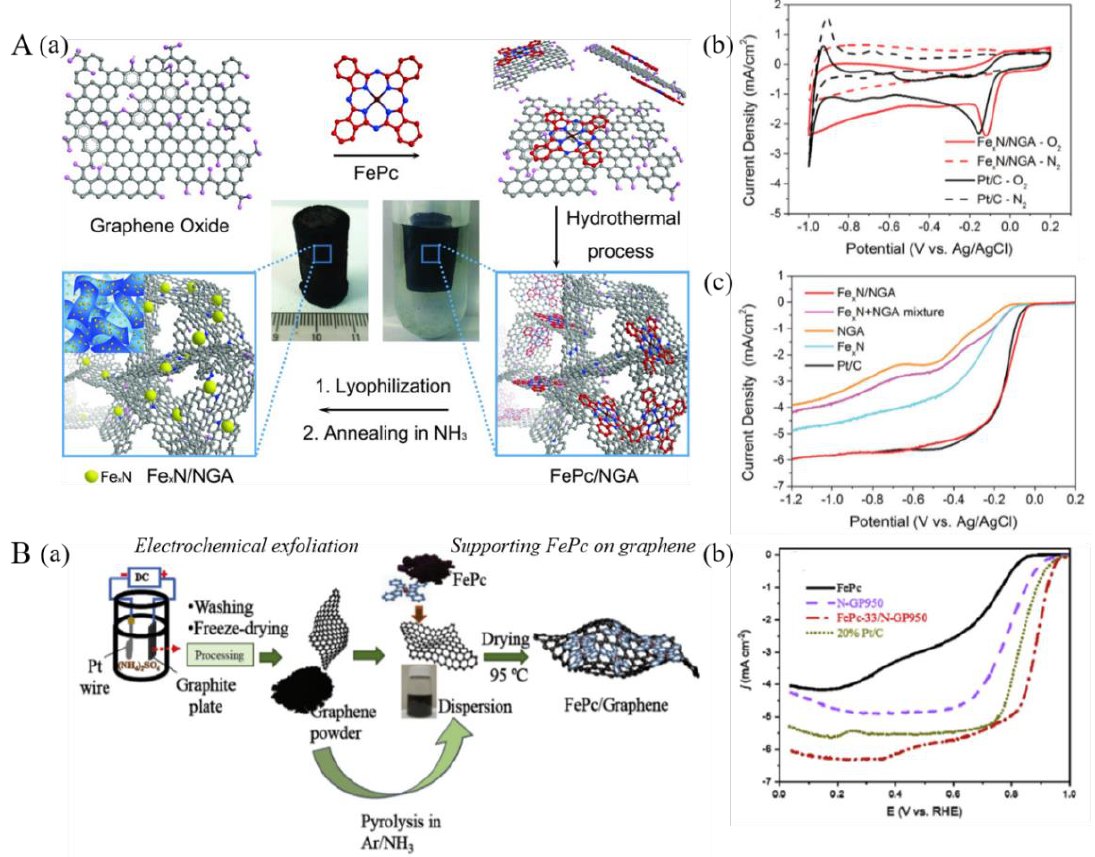
Figure 5. ( A) ( a ) Schematic of the preparation of the Fe x N/NGA catalyst, ( b ) CV curves of Fe x